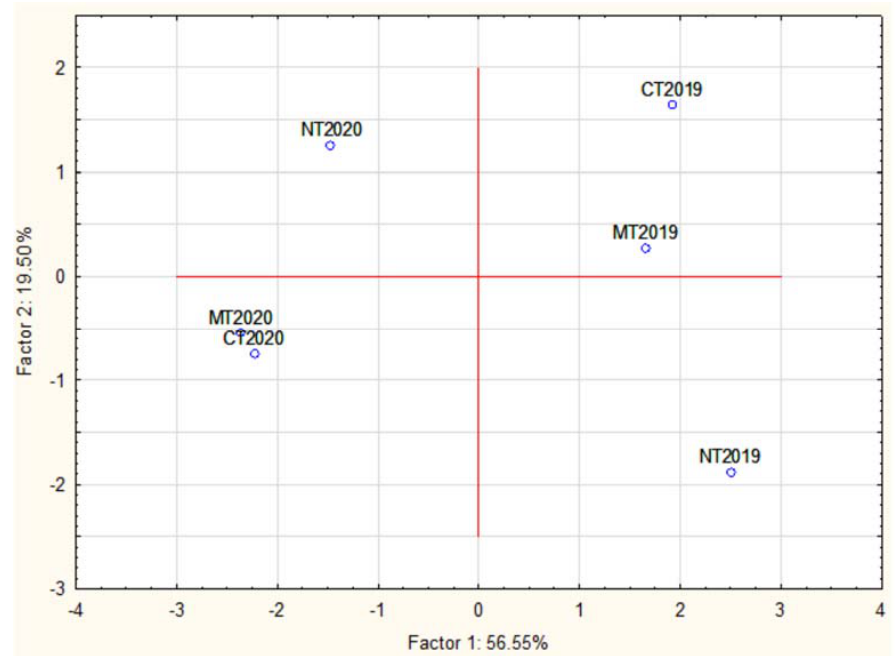
Figure 2. Projection of the tillage systems on the factor plan (1–2). Please note: NT: No ‐ tillage; MT: Minimum tillage; CT: Conventional tillage. The number following the tillage system refers to the year of cultivation.